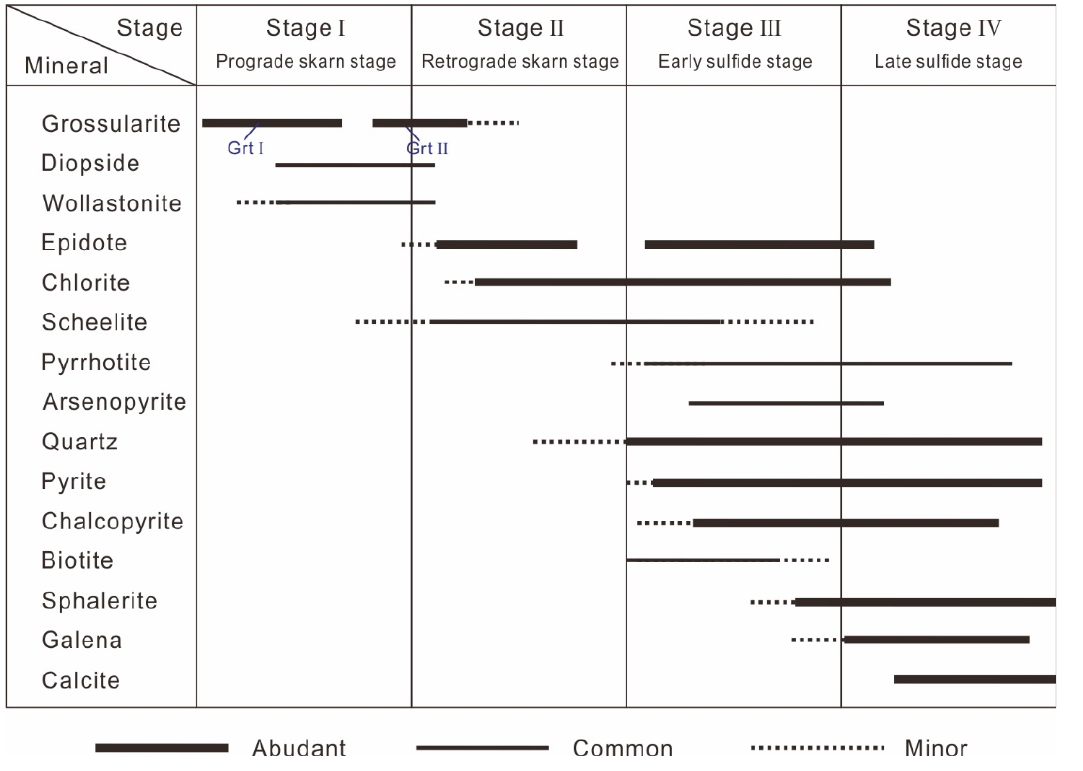
Figure 5. The paragenesis of minerals formed at various stages of the Tongshanling Cu–W–Pb–Zn polymetallic deposit.